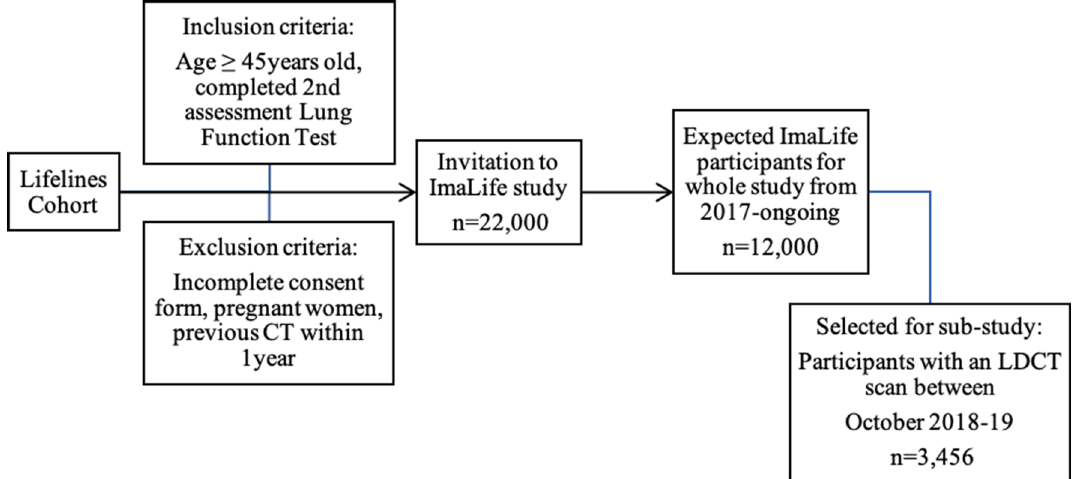
Figure 4. Overview of the ImaLife study and participants included in this sub-study. LDCT low-dose computed